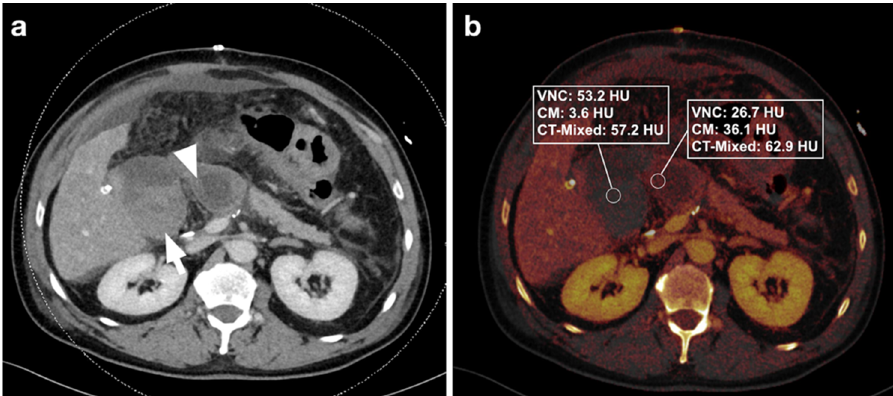
Figure 2. ( a ) 59-year-old male patient with intra-abdominal hematoma (arrow) adjacent to small bowel loops (arrowhead) after Whipple surgery for pancreatic cancer. ( b ) Measurements in iodine maps show a difference in VNC and iodine values (dual-energy CT) between hematoma and intestinal loops, but no difference in DE-LB (single-energy CT). After CT, the patient was reoperated, and the hematoma was removed.